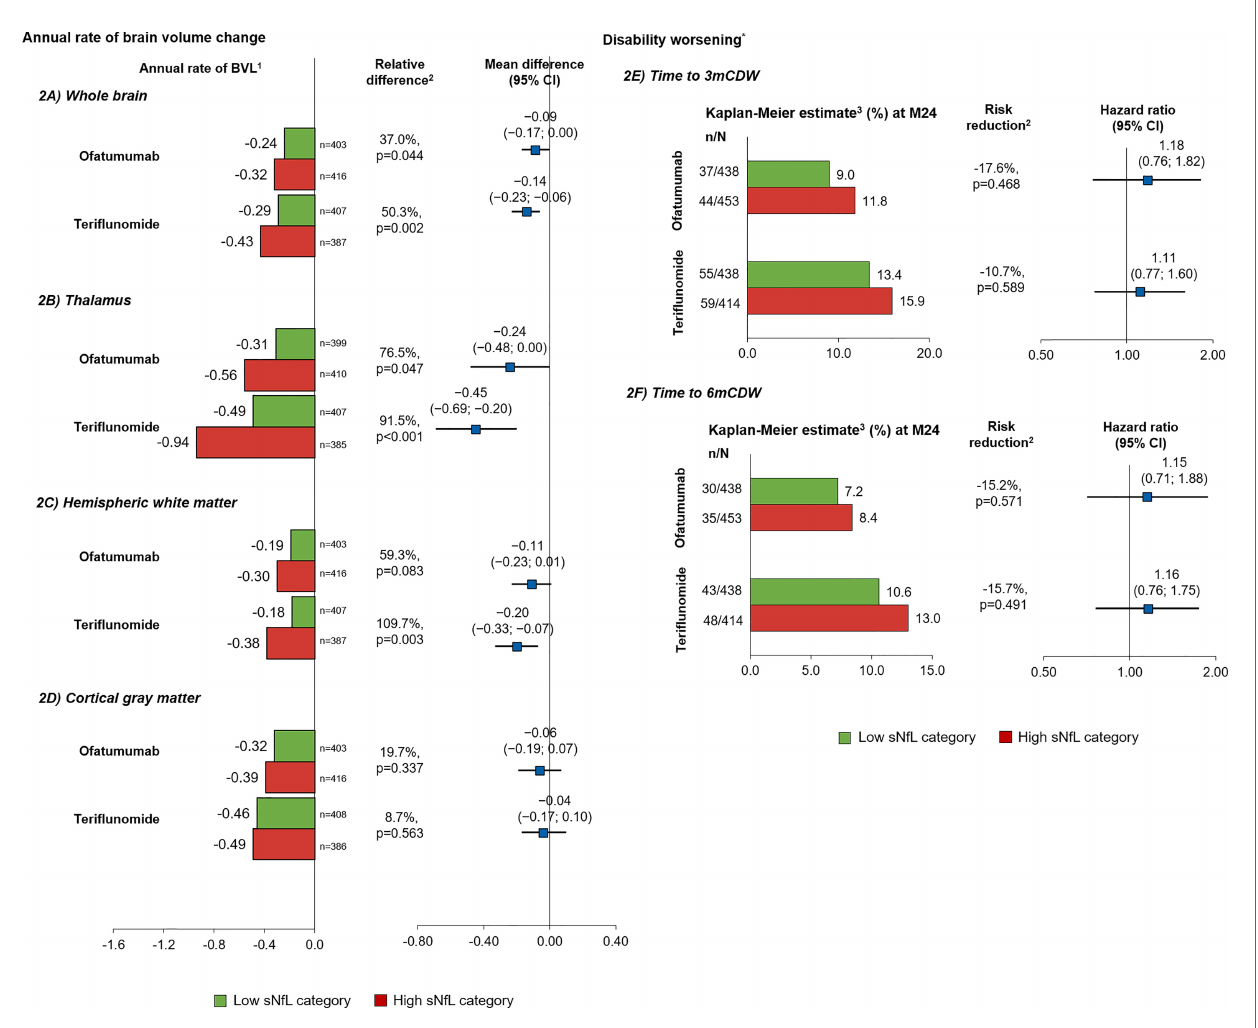
FIGURE 2 | Prognostic value of baseline sNfL [high (red), ≥ 9.3 pg/ml; low (green), <9.3 pg/ml] on brain volume change and disability worsening in the overall study population*. Annual rate of brain volume change in (A) whole brain, (B) thalamus, (C) hemispheric white matter, and (D) cGM per year; time to disability worsening (E) 3mCDW and (F) 6mCDW by NfL baseline category. Comparisons are between high vs. low sNfL categories. 1 Adjusted annual rate of brain volume change as estimated in from the random coef fi cient model with study fi t to the post-baseline assessments measured at M12, M24, and end-of-study, treatment as fi xed effects (factors), and time as continuous covariates and treatment by time interaction for the overall analysis, with additional co-factors of subgroup, treatment by subgroup, treatment by time by subgroup interactions for the subgroup analysis. Random terms for slopes and intercept are included. 2 Indicates statistical signi fi cance (two- sided) at the 0.05 level. Obtained from a random coef fi cients model. 3 Cox regression adjusted study as stratum, treatment, region, and sNfL baseline high – low subgroup as factors and baseline EDSS as a continuous covariate along with treatment-by-sNfL baseline high – low subgroup interaction. *Descriptive analysis; the study was not powered to analyze prognostic effects of sNfL on disability outcomes. 3m, 3month; 6m, 6month; ARR, annualized relapse rate; CDW, con fi rmed disability worsening; cGM, cortical gray matter; CI, con fi dence interval; EDSS, Expanded Disability Status Scale Score; Gd+, gadolinium-enhancing; LS, least square; M, month; sNfL, serum neuro fi lament light; WM, white